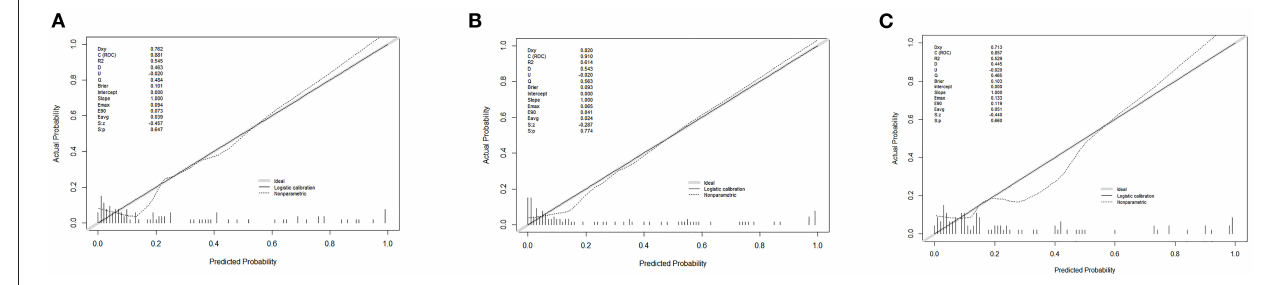
FIGURE 4 | Calibration curves for the three predictive models. (A) Predictive model A, (B) predictive model B, and (C) predictive model C.